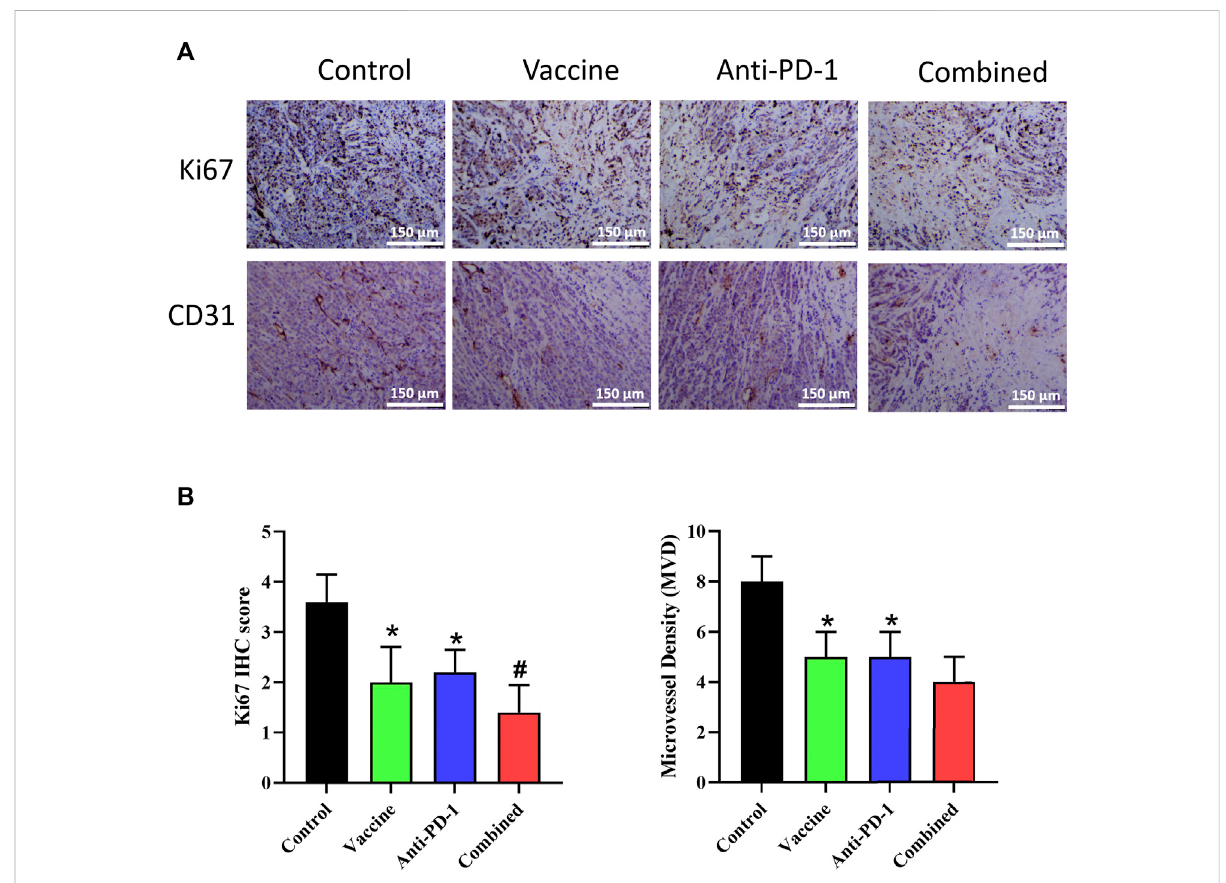
FIGURE 5 Effect of vaccine, PD-1 blockage and combination therapy on cellular proliferation, and vessel density in tumors. (A,B) Ki67 + cells and microvessel density are quanti fi ed in mice treated with different therapy. Statistical signi fi cance was measured using Student ’ s t-test and one-way ANOVA. *, p < 0.05 vs. Control; #, p < 0.05 vs. Anti